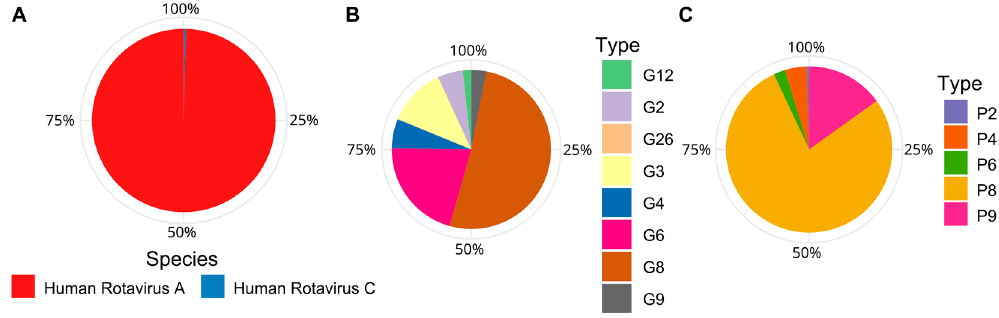
Figure 5. Relative abundances of Human Rotavirus species and genotypes inferred from Pfam annotated VP4, VP6, and VP7 genes and classified by local alignment (BLASTn) to NCBI nt database. Sequences were normalized by gene length. ( A ) Relative abundance of Human Rotavirus species based on VP6. ( B ) Relative abundance of Human Rotavirus G types based on VP7. ( C ) Relative abundance of Human Rotavirus P types based on VP4.